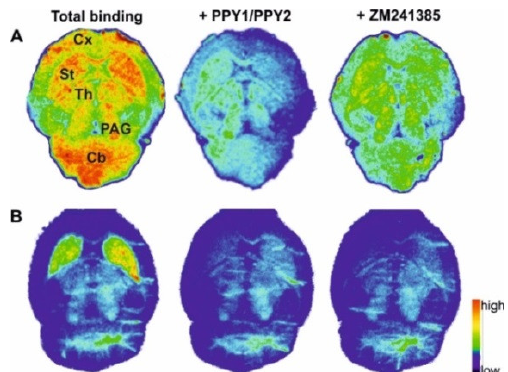
Figure 8. Representative autoradiographic images of the transversal plane of mouse brain slices representing total binding of ( A ) [ 18 F] PPY1 and ( B ) [ 18 F] PPY2 . Non-specific binding is depicted in the presence of either 1 µM PPY1 , PPY2 or ZM241385 . Abbreviations: Cb—cerebellum; Cx—cor-